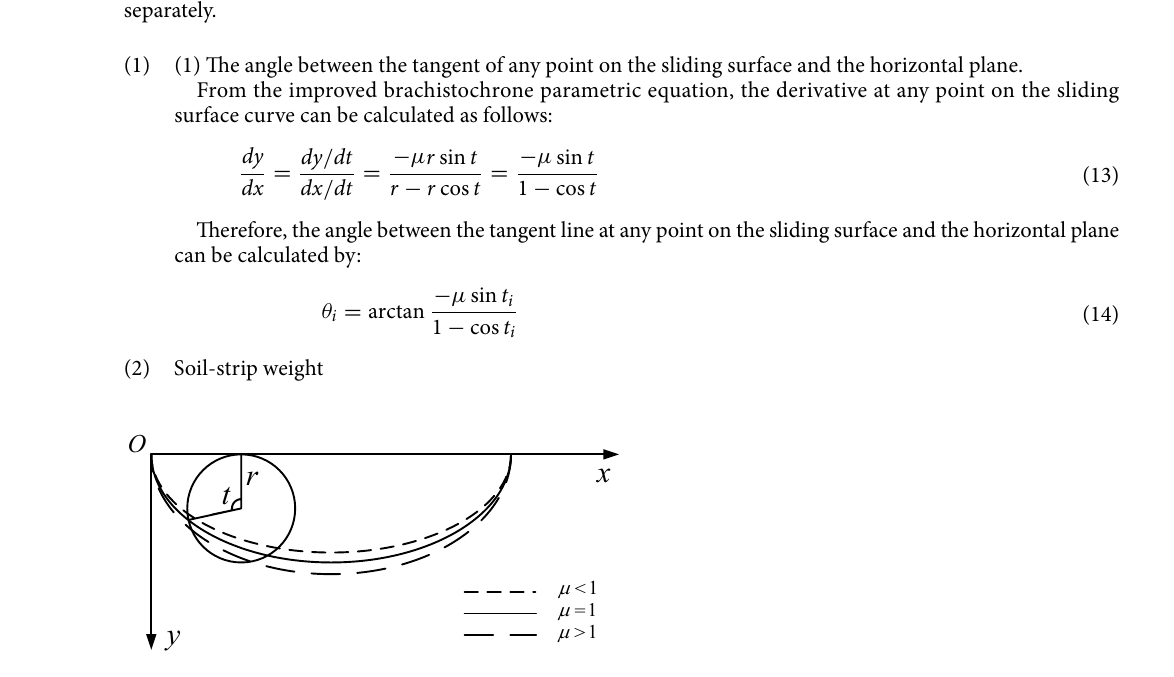
Figure 5. Schematic diagram of